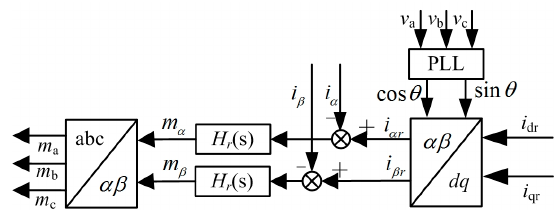
Figure 2. Block diagram of LCL-type inverter with IC feedback.